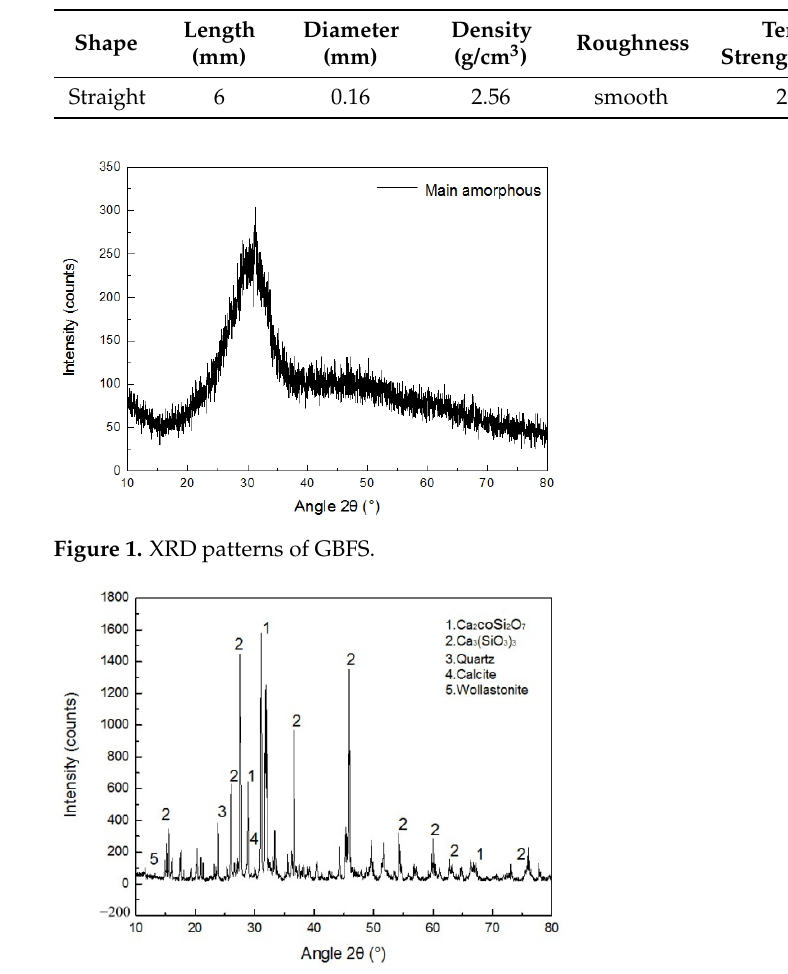
Figure 2. XRD patterns of silicomanganese slag.